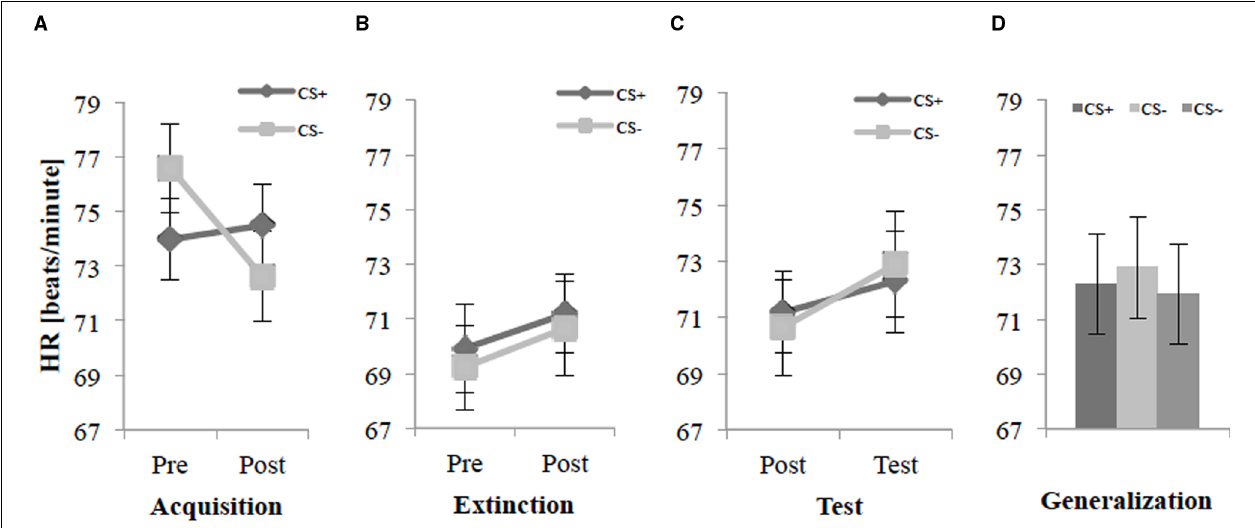
FIGURE 3 | Heart rate ( n = 28) for CS + and CS (cid:0) pre and post acquisition (A), extinction (B), and test phase (C) as well as the generalization effect (D) for CS + , CS (cid:0) , and CS (cid:24) during test phase. Note: CS + , agents with aversive unconditioned stimulus (US); CS (cid:0) , agents